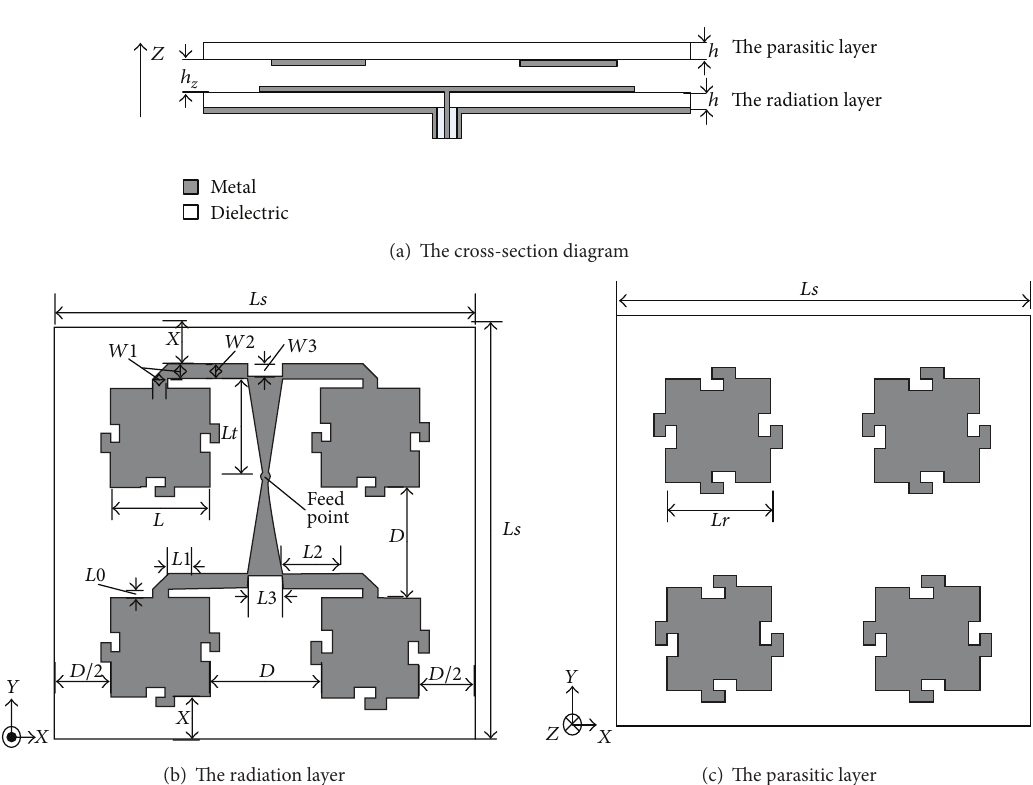
Figure 3: Configuration of the proposed microstrip antenna